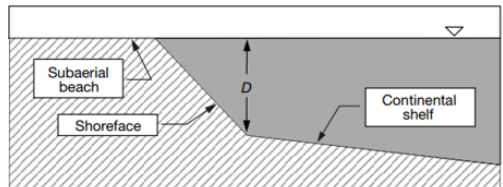
Figure 2. Cross-sectional profile of CEM showing the location of the depth of closure, where the shoreface slope intersects the conti- nental shelf slope (following Ashton et al., 2001).